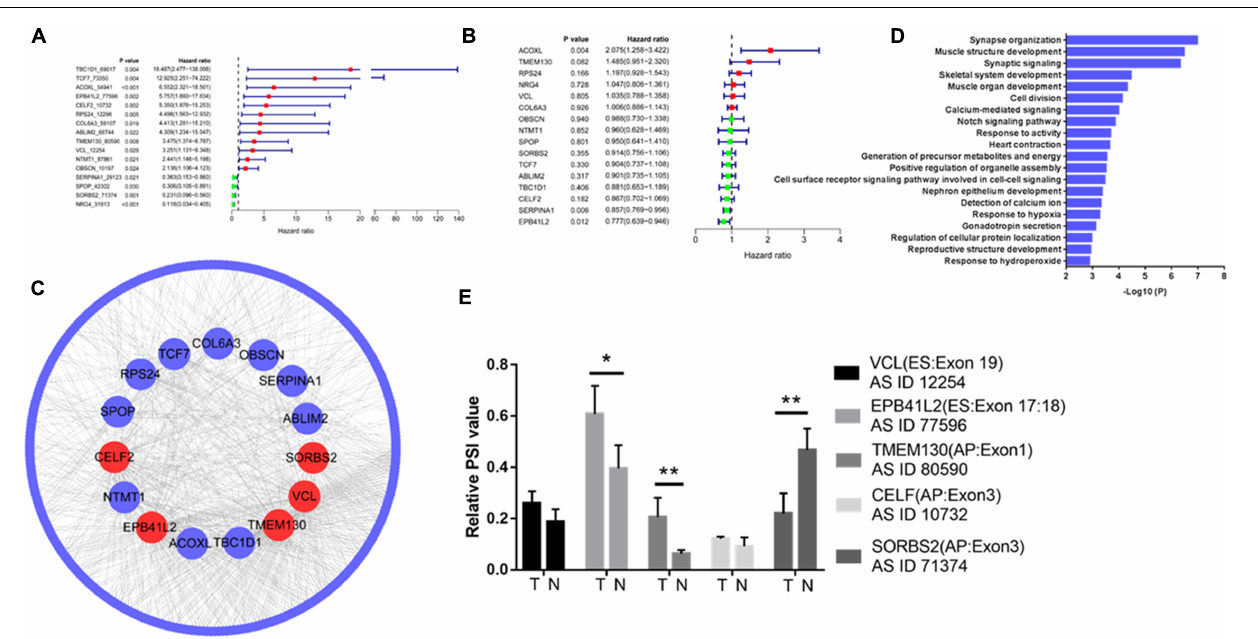
FIGURE 2 | Integrated analysis reveals hub gene AS events in colorectal cancer. Differentially expressed AS events of genes (A) and differentially expressed genes (B) associated with prognosis in colorectal cancer. (C) Coexpression network of gene expression and gene AS events identified five hub gene AS events: EPB41L2, CELF2, TMEM130, VCL, and SORBS2 ( R > 0.3, p < 0.001). (D) Gene Ontology (GO) analysis of the 300 genes whose mRNA levels were significantly related to the hub gene AS events in colorectal cancer (CRC). (E) EPB41L2, CELF2, TMEM130, VCL, and SORBS2 expression in five paired normal and tumor tissues